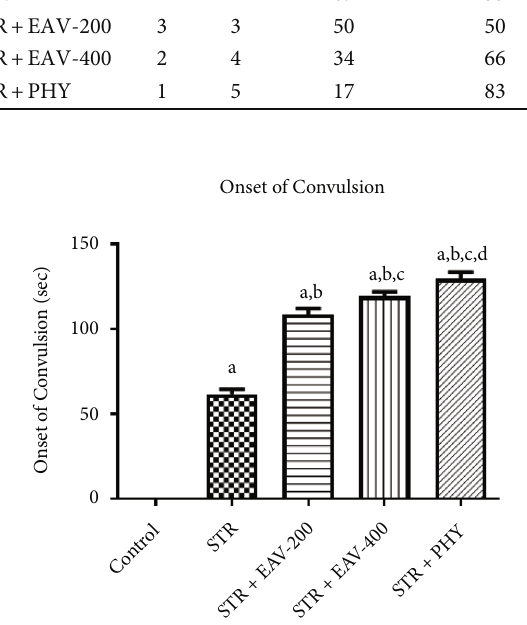
Figure 1: Graph showing the impact of EAV-200, EAV-400, and PHY on strychnine-induced convulsion onset. All values are mean ± SEM ( n = 6 ). a p < 0 : 001 compared to control, b p < 0 : 001 compared to STR, c p < 0 : 001 compared to STR +EAV-200, c p < 0 : 05 STR +EAV-400 compared to STR+ EAV-200, d p < 0 : 05 STR +PHY compared to STR+ EAV-400 (one-way ANOVA followed by Student – Newman – Keuls post hoc test).